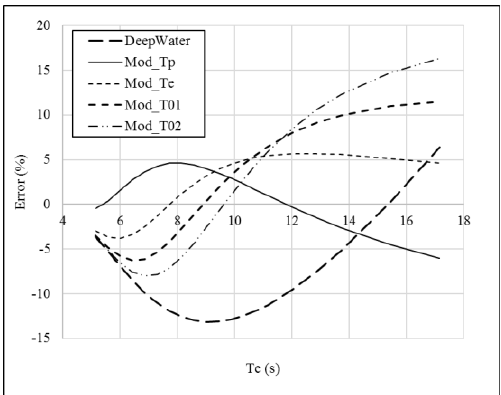
Figure 9. Errors for deep-water formulas and modifications using different periods ( h = 25 m).